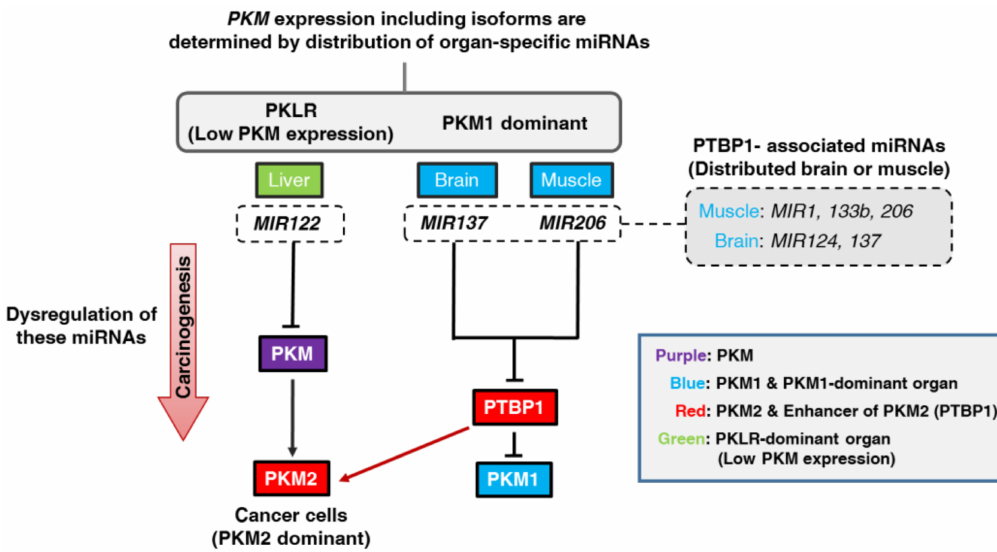
Figure 5. Schematic diagram of our study findings. PKLR and PKM isoforms showed organ specificity; i.e., PKLR was dominantly expressed in the liver. PKM1 was dominantly expressed in the brain and muscle. In the liver, liver-specific MIR122 suppressed the PKM expression by dominant distribution of MIR122 . In the brain and muscle, brain-specific MIR137 and muscle-specific MIR206 induced the upregulation of the PKM1 expression through the suppression of the PTBP1 expression. Previously, we proved that muscle-specific MIR1 and 133b and brain-specific MIR124 had the same mechanism for PKM isoform expression. These organ-specific miRNAs, which targeted PTBP1 directly, regulate PKM isoform expression by their tissue distribution. We named these miRNAs PTBP1 -associated miRNAs. Also, dysregulation of these organ-specific miRNAs strongly contributed to carcinogenesis by promoting PKM2 expression in cancer cells (Red arrow). Colors indicate the following: Purple; PKM gene, Blue; PKM1 and PKM1 -dominant organ, Red; PKM2 and enhancer of PKM2 ( PTBP1 ), Green; PKLR- dominant (low PKM expression)